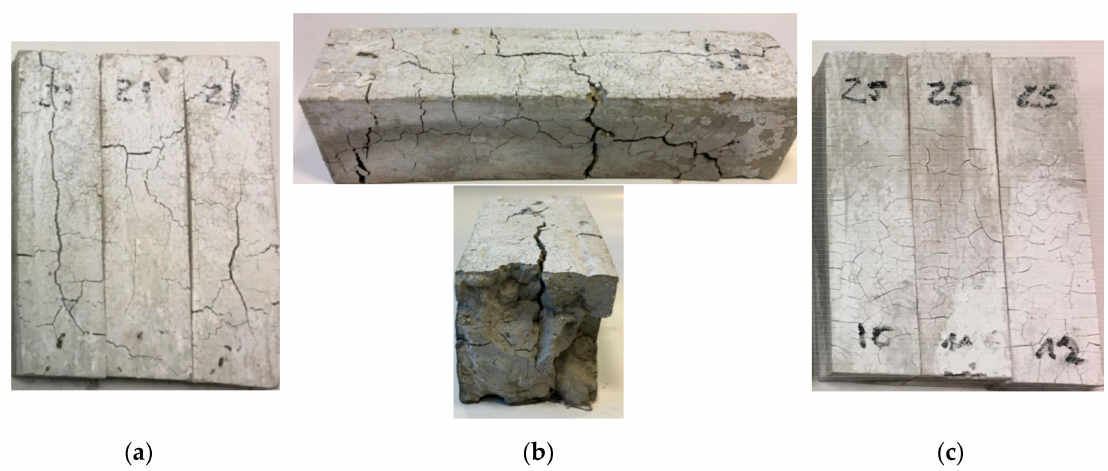
Figure 6. ( a ) Z1 samples after 60 min in the furnace; ( b ) Zoom on Z1 sample after 60 min in the furnace; ( c ) Z5 samples after 60 min in the furnace.